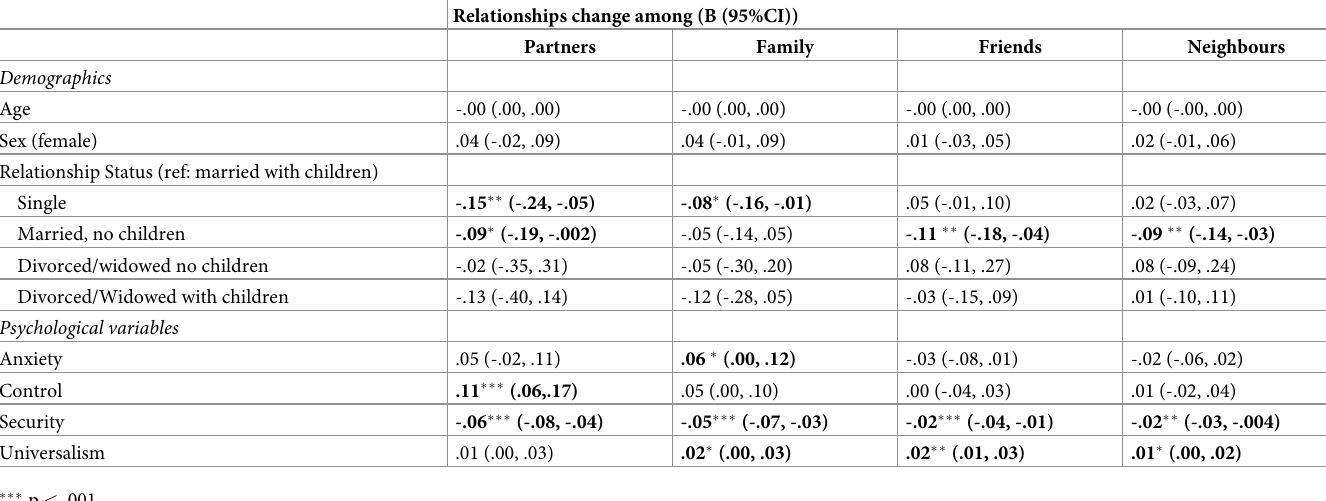
and neighbours allocated to another, second/third circles group. Comparing changes in rela- tionships between the two groupings indicated positive change was greatest amongst those in the “inner circle” (Ms = 2.22 vs. 1.96; t = 17.56, p = .001). We then considered associations between relationship change and perception of the virus and respondent demographics and values. There were no significant zero-order correlations between averaged relationship change and anxiety (r (1000) = -.03, p = .41) or universalism (r (1000) = -.03, p = .38), but there was a small positive association between relationship change and perceived control (r (1000) = .06, p = .05) and a negative association between relationship change and security (r (1000) = -.16, p = .001). There was no significant correlation between anxiety and security (r (1000) = -.00, p = .95), but anxiety and universalism were negatively associated (r (1000) = -.08, p = .011). Multiple regressions for each relationship included as covariates age, sex, marital status (dummy coded), anxiety, perceived control, and the two values (Table 2). Participants Table 2. Anxiety, values, demographics and relationship change. Relationships change among (B